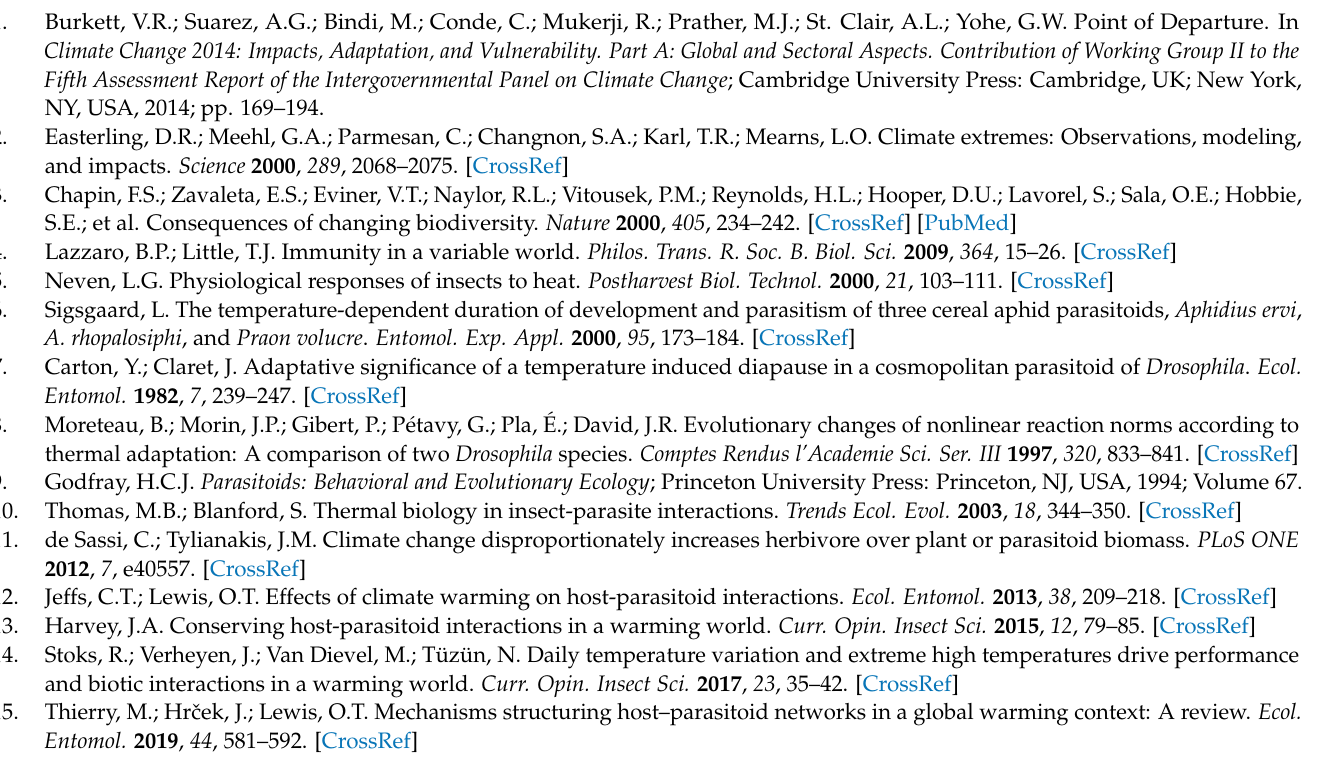
Table S7: Summary of pairwise contrasts (relative intensity of LbGAP, LbGAP2 and LbSPN). Table S8: Summary of pairwise contrasts (total band intensity), Table S9: PERMANOVA for venom variation in each parasitoid line, Table S10: Correlation values of L. boulardi ISm bands to linear regression (arrow from LDA) before and after partial correlation analysis, Table S11: Correlation values of L. boulardi ISy bands to linear regression (arrow from LDA) before and after partial correlation